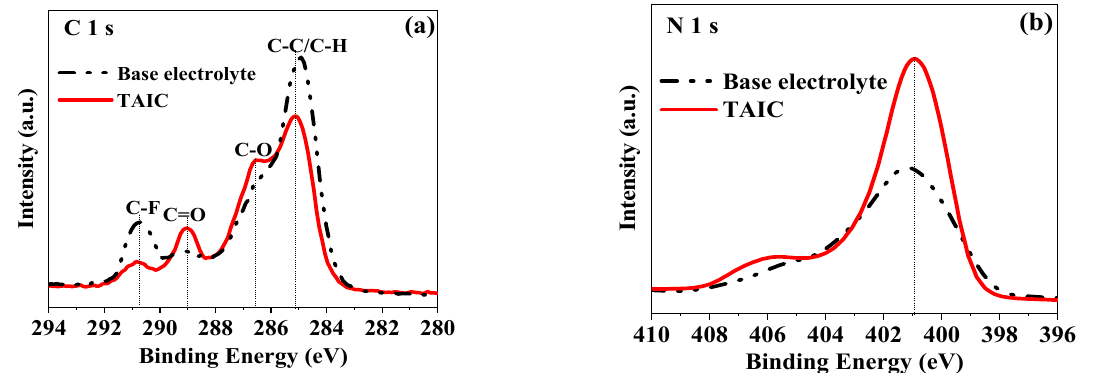
Figure 8. XPS spectra of LiCoO 2 after cycling in base and 0.5 wt.% TAIC-containing electrolytes: ( a ) C1s; ( b ) N1s.